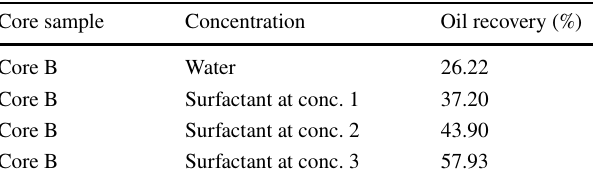
Table 6 Core flooding parameters and result for surfactant at different concentrations at 0.2 wt% to 0.5wt% for core B